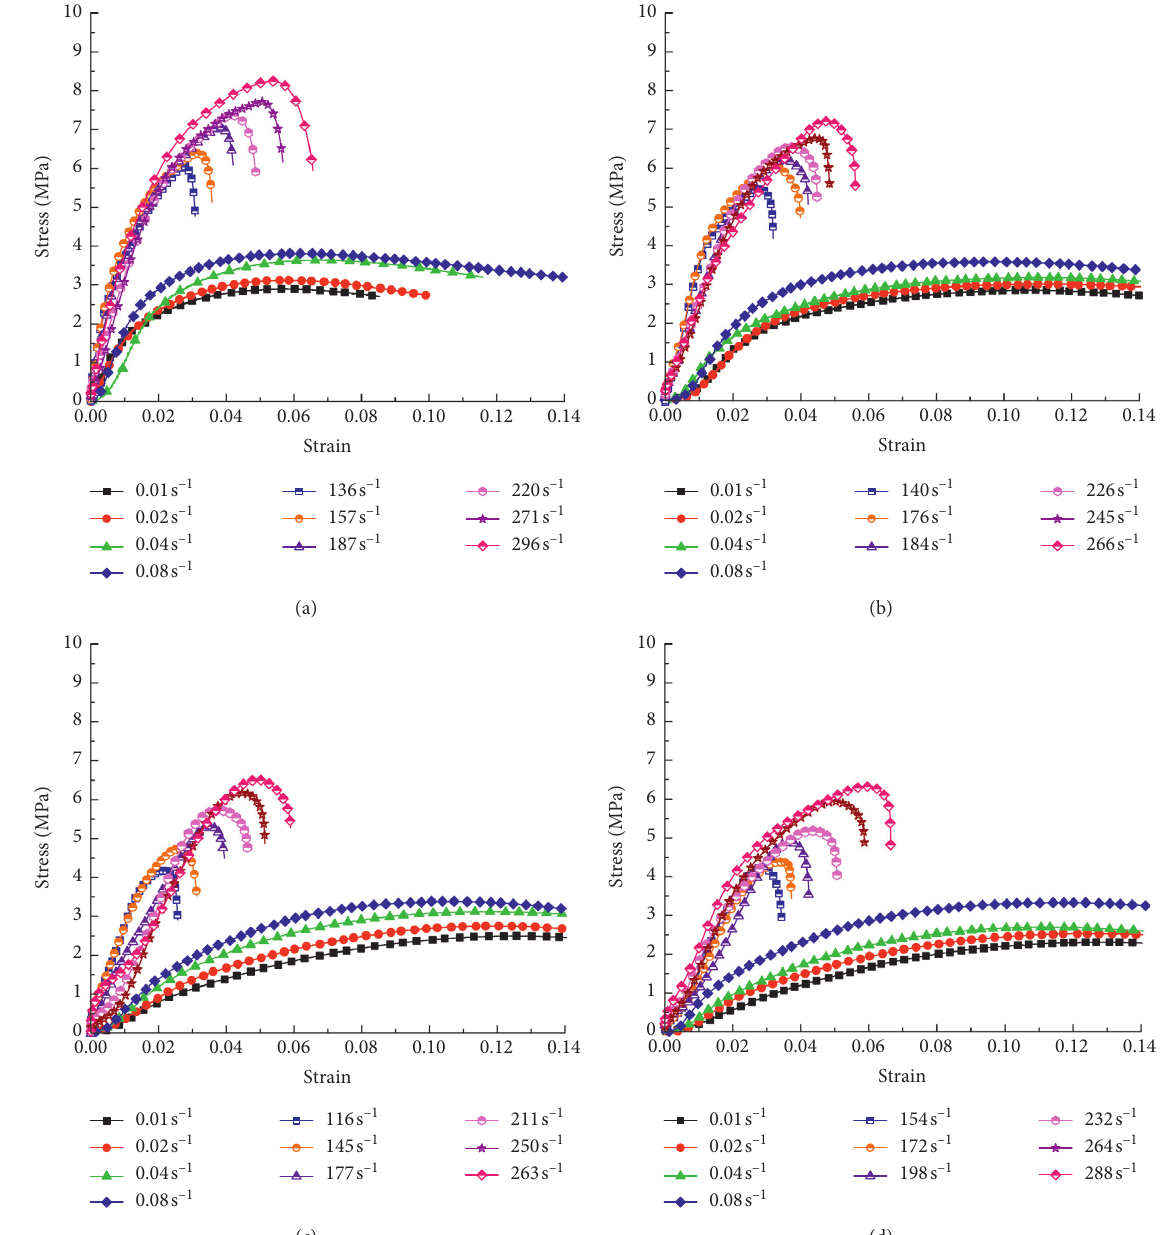
Figure 6: Stress-strain curves of frozen silty soil with various prefabricated crack numbers and strain rates. (a) 0 prefabricated cracks. (b) 1 prefabricated crack. (c) 2 prefabricated cracks. (d) 3 prefabricated